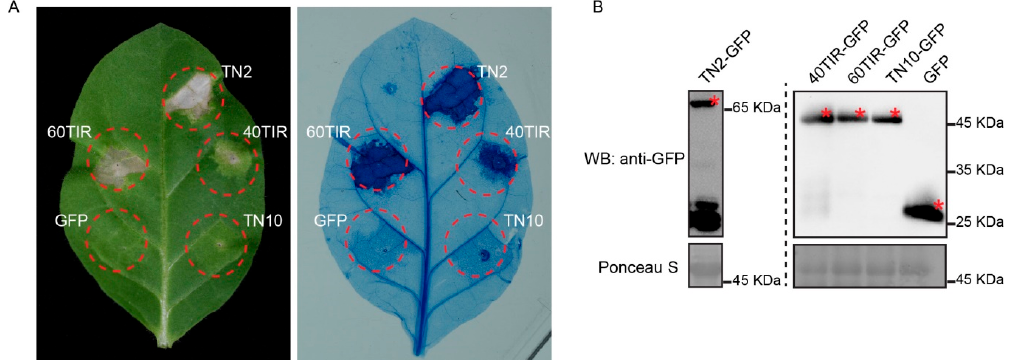
Figure 5. Transient overexpression of TNL40TIR and TNL60TIR in tobacco results in cell death. ( A ) Transient overexpression of TNL40TIR, TNL60TIR, and TN10 in N. tabacum leaves and the cell death were observed and photographed at 3 days after injection. TN2-GFP was used as a positive control and GFP was used as a negative control. ( B ) Immunoblotting analysis of the accumulation of TN2-GFP, TNL40TIR-GFP, TNL60TIR-GFP, TN10-GFP, and GFP proteins in N. tabacum leaves before cell death occurred. Asterisks indicate the position of the corresponding proteins.